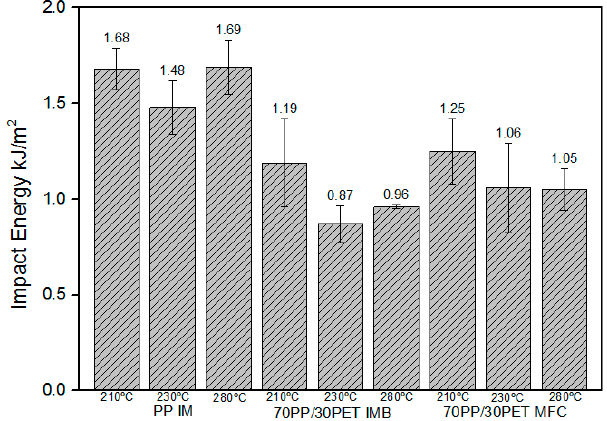
Figure 11. Comparison of impact energy (kJ/mm) of PP IM, 70PP/30PET IMBs, and 70PP/30PET MFCs at three different T im .